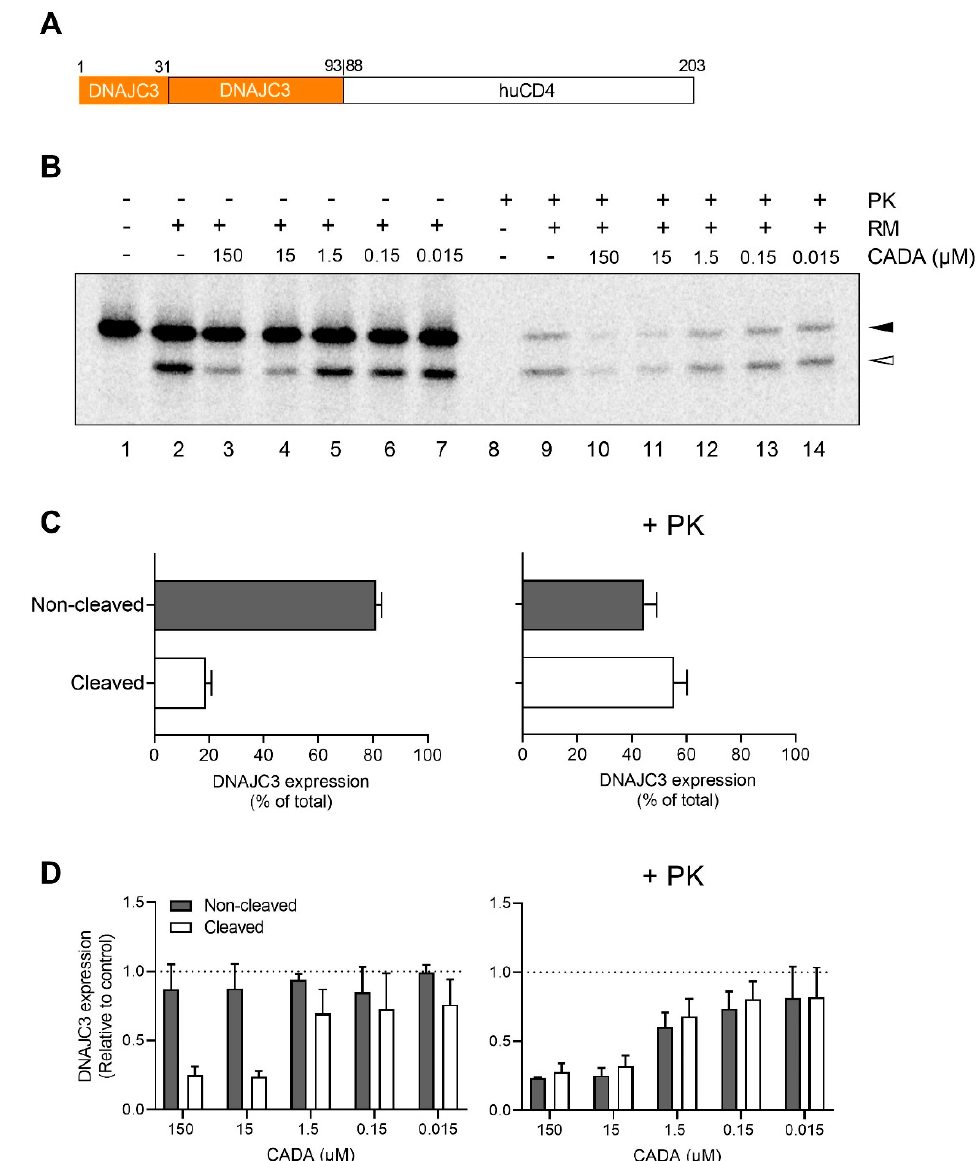
Figure 2. CADA inhibits the signal peptide-dependent co-translational translocation of the ER lumenal DNAJC3 protein. ( A ) Representation of the construct used for cell-free in vitro translation and translocation assay. ( B ) Cell-free in vitro translation and translocation in rabbit reticulocyte lysate supplemented with ovine microsomes, CADA and proteinase K (PK). Autoradiogram of the in vitro translated and translocated DNAJC3-huCD4 chimaeric protein. In the presence of rough microsomes (RM), the preprotein (black arrowhead) was translocated into the ER lumen and the SP was cleaved, resulting in a faster migrating mature protein (open arrowhead). One representative experiment out of three is shown. ( C ) Percentage of non-cleaved (black arrowhead, preprotein) and cleaved (open arrowhead, mature protein) DNAJC3 protein in the DMSO-treated control sample of untreated and PK-treated samples. Samples from (A, lane 2 and lane 9) were quantified. Bars are mean ± SE; n = 3. ( D ) CADA sensitivity of the non-cleaved and cleaved DNAJC3 protein fraction in control samples and PK-treated samples. Samples from A (lanes 2–7 and 9–14) were quantified and normalised to the respective protein fraction in the DMSO control (lane 2 or 9). Bars are mean ± SE; n = 3. CADA: cyclytriazadisulfonamide; DNAJC3: DnaJ homolog subfamily C member 3; PK: Proteinase K; RM: rough microsomes; ER: endoplasmic reticulum; SP: signal peptide; DMSO: dimethyl sulfoxide.